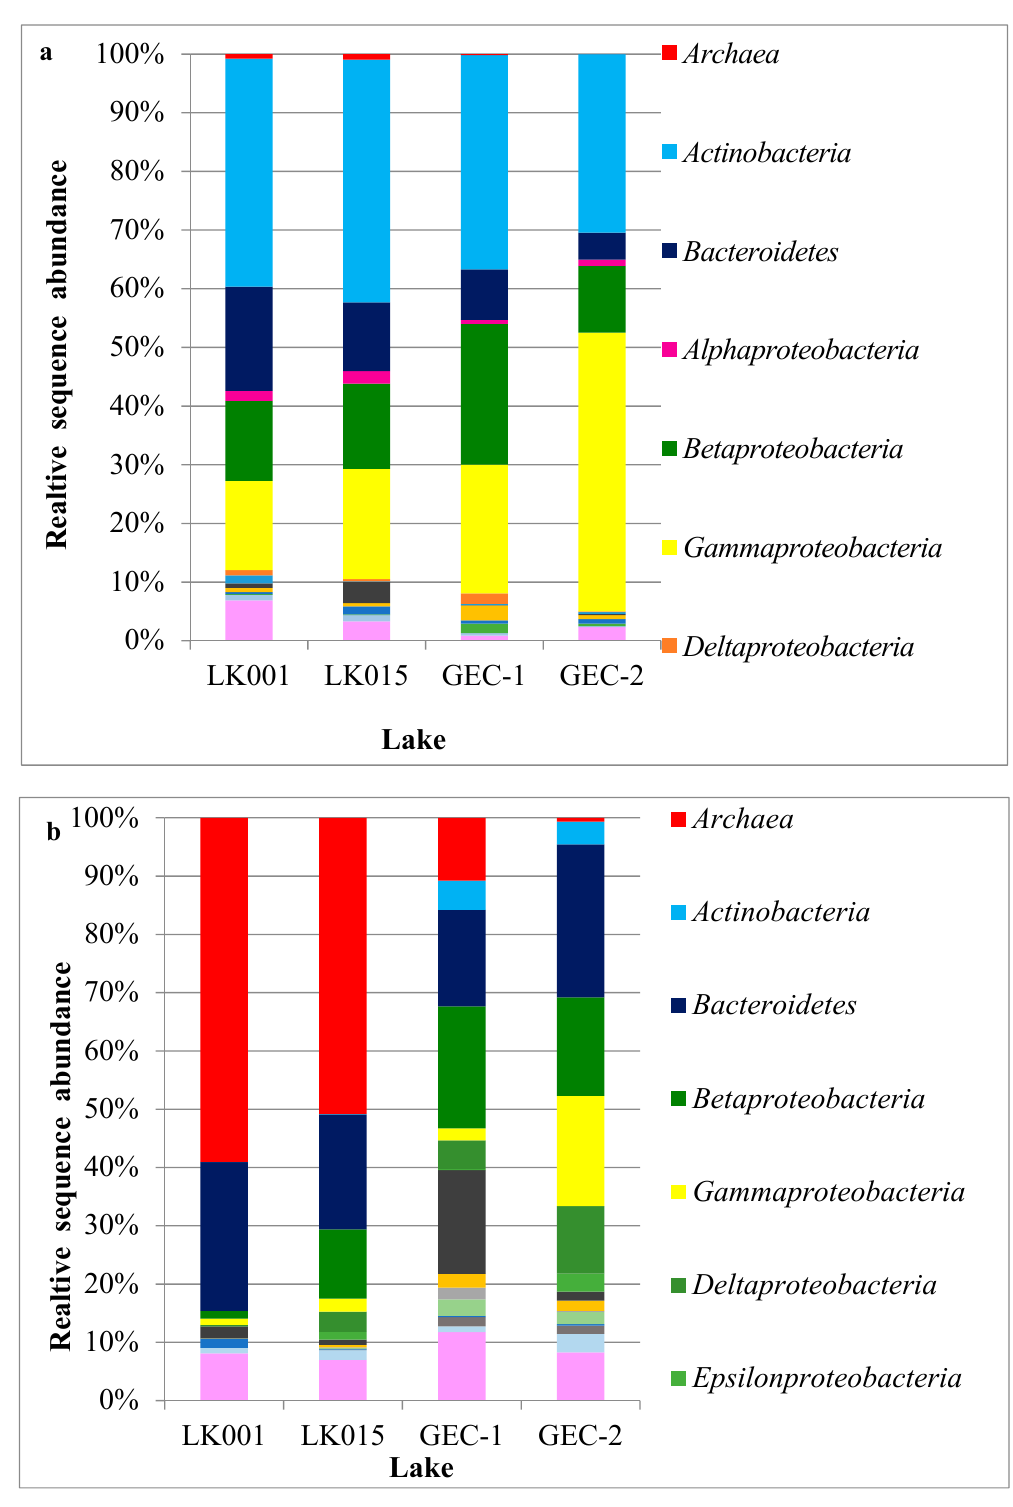
Figure 6. Microbial diversity in the bottom water ( a ) and upper sediment layer ( b ) of the Yamal background lakes (LK001, LK015) and gas emission craters (GEC-1, GEC-2) as determined by high-throughput sequencing of the 16S rRNA gene fragments (April